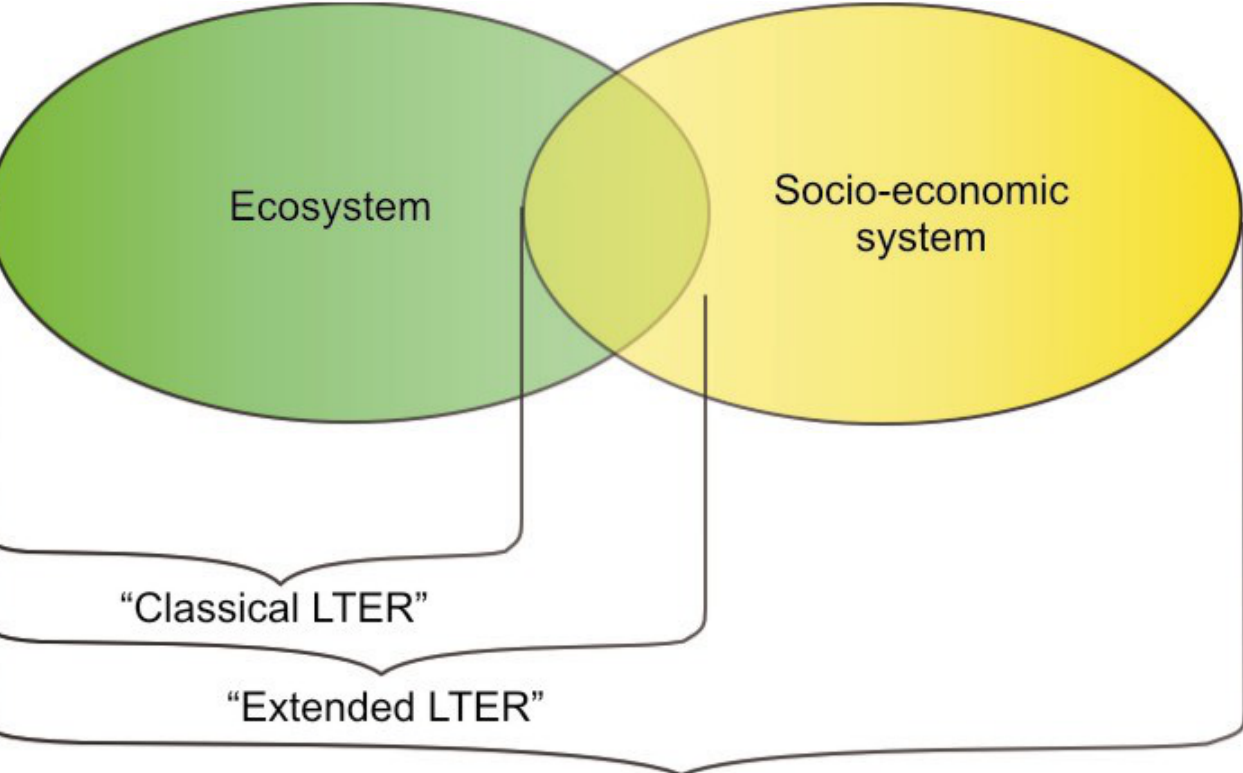
Fig. 2. Whereas extended LTER focuses on more or less human-modified natural systems, LTSER must deal with socioecological systems that emerge through the interaction between ecosystems and socioeconomic